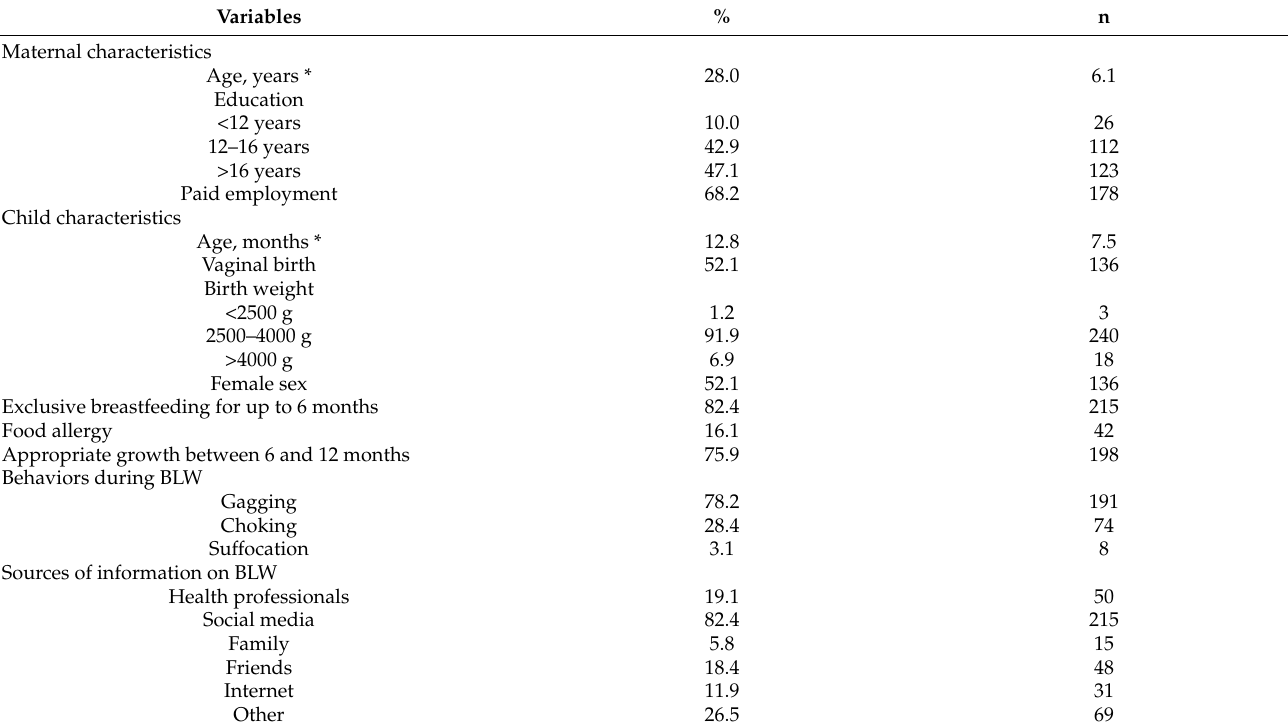
Table 1. Maternal and child characteristics and information sources on BLW